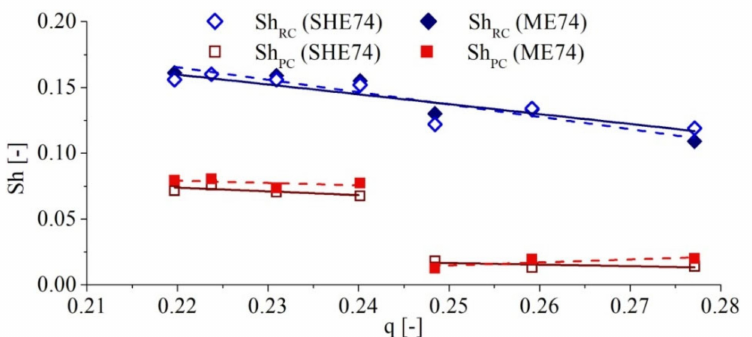
Figure 8. Strouhal numbers of the fundamental frequencies corresponding to the rotating (blue) and plunging (red) components induced by the self-induced flow instabilities and the interaction of the swirling flow with two draft tube configurations ( ♦ (cid:3) SHE74 and (cid:7) (cid:4) ME74) versus the discharge coefficient. Linear fits of the experimental data given by solid and dashed lines highlight the